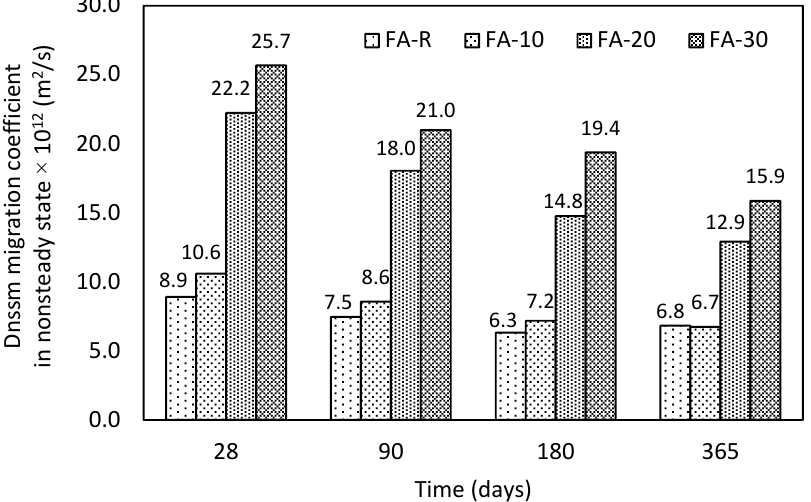
Figure 10. Obtained results of the chloride ion penetration test in time.